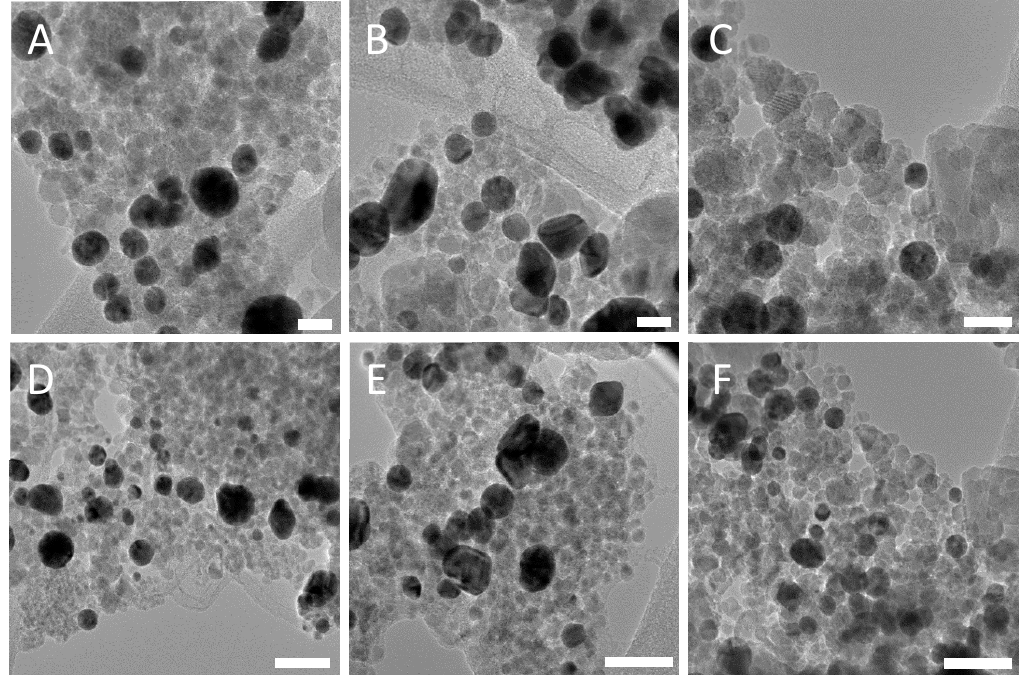
Figure 7. TEM images of PSS-stabilised Fe 3 O 4 and PAH-stabilised Au nanoparticles. Scale bars are 20 nm in ( A–D ) and 50 nm in ( E , F ). ( A , D ) are 1.90 × 10 − 5 M PSS-stabilised Fe 3 O 4 and gold nanoparticles, ( B , E ) are 1.43 × 10 − 5 M PSS-stabilised Fe 3 O 4 nanoparticles and gold nanoparticles; and ( C , F ) are 7.14 × 10 -6 M PSS-stabilised Fe 3 O 4 nanoparticles and gold nanoparticles.